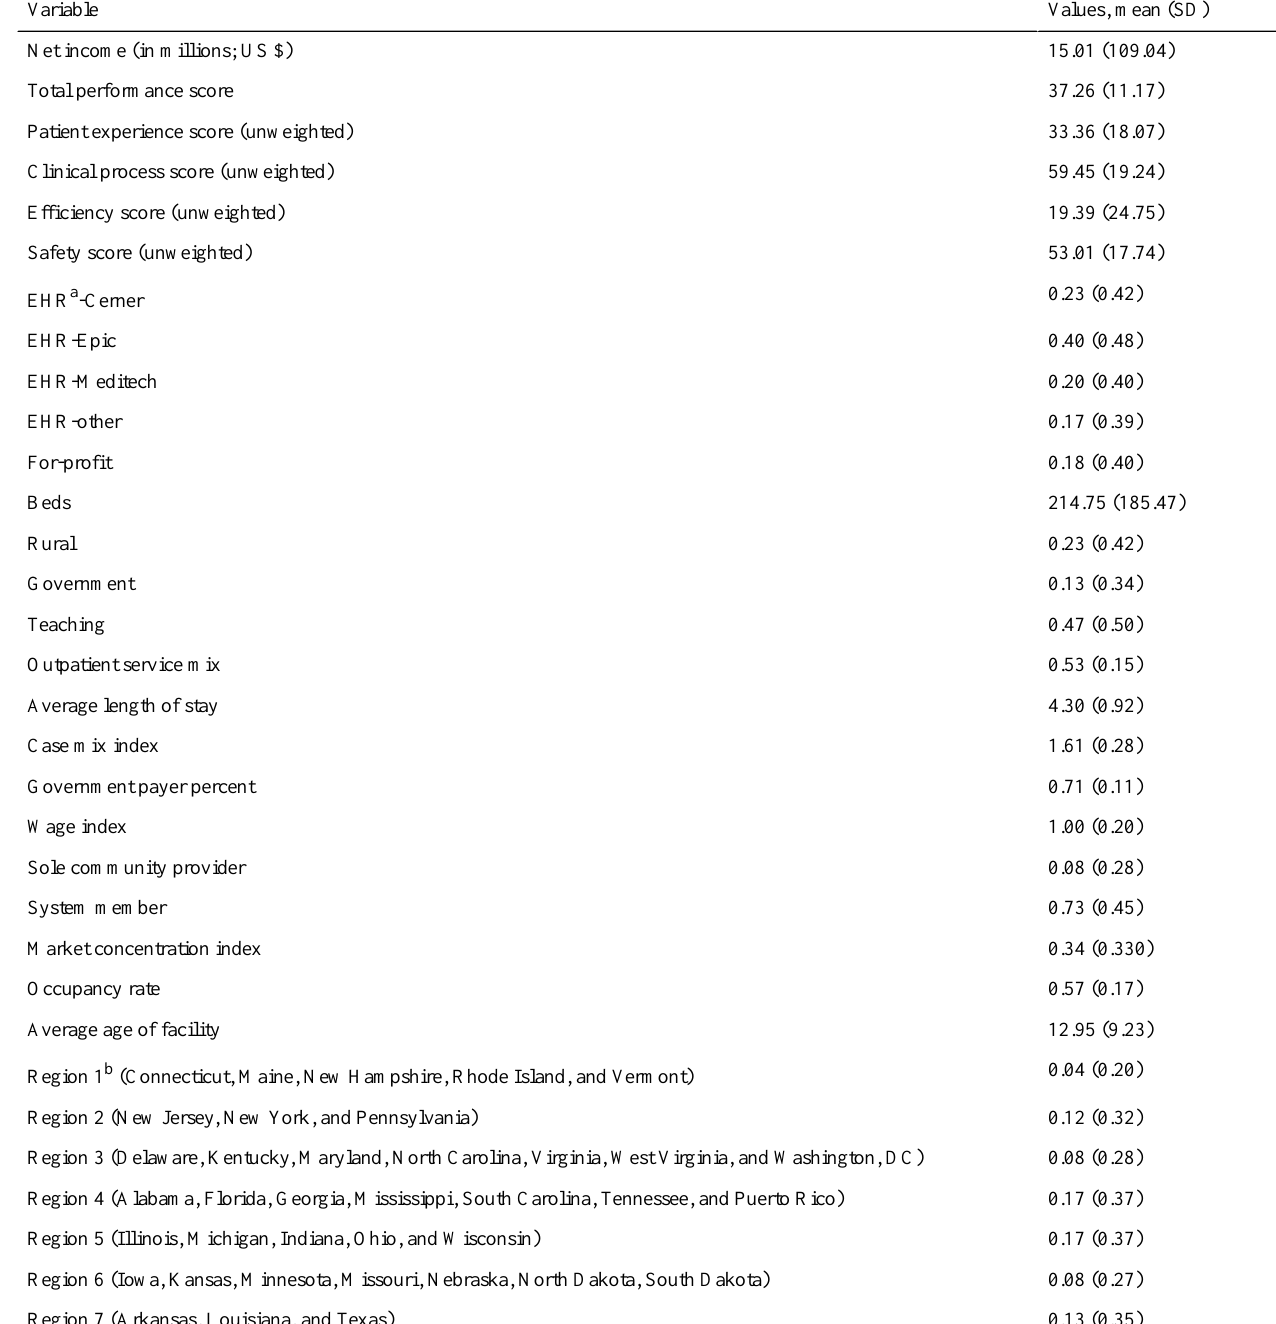
Table 2. Descriptive statistics.